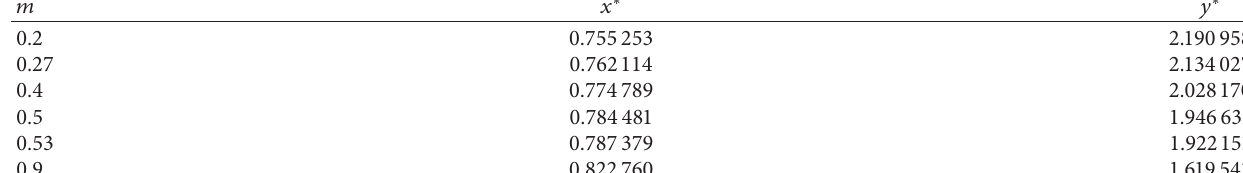
Table 1: The equilibrium point values of Case